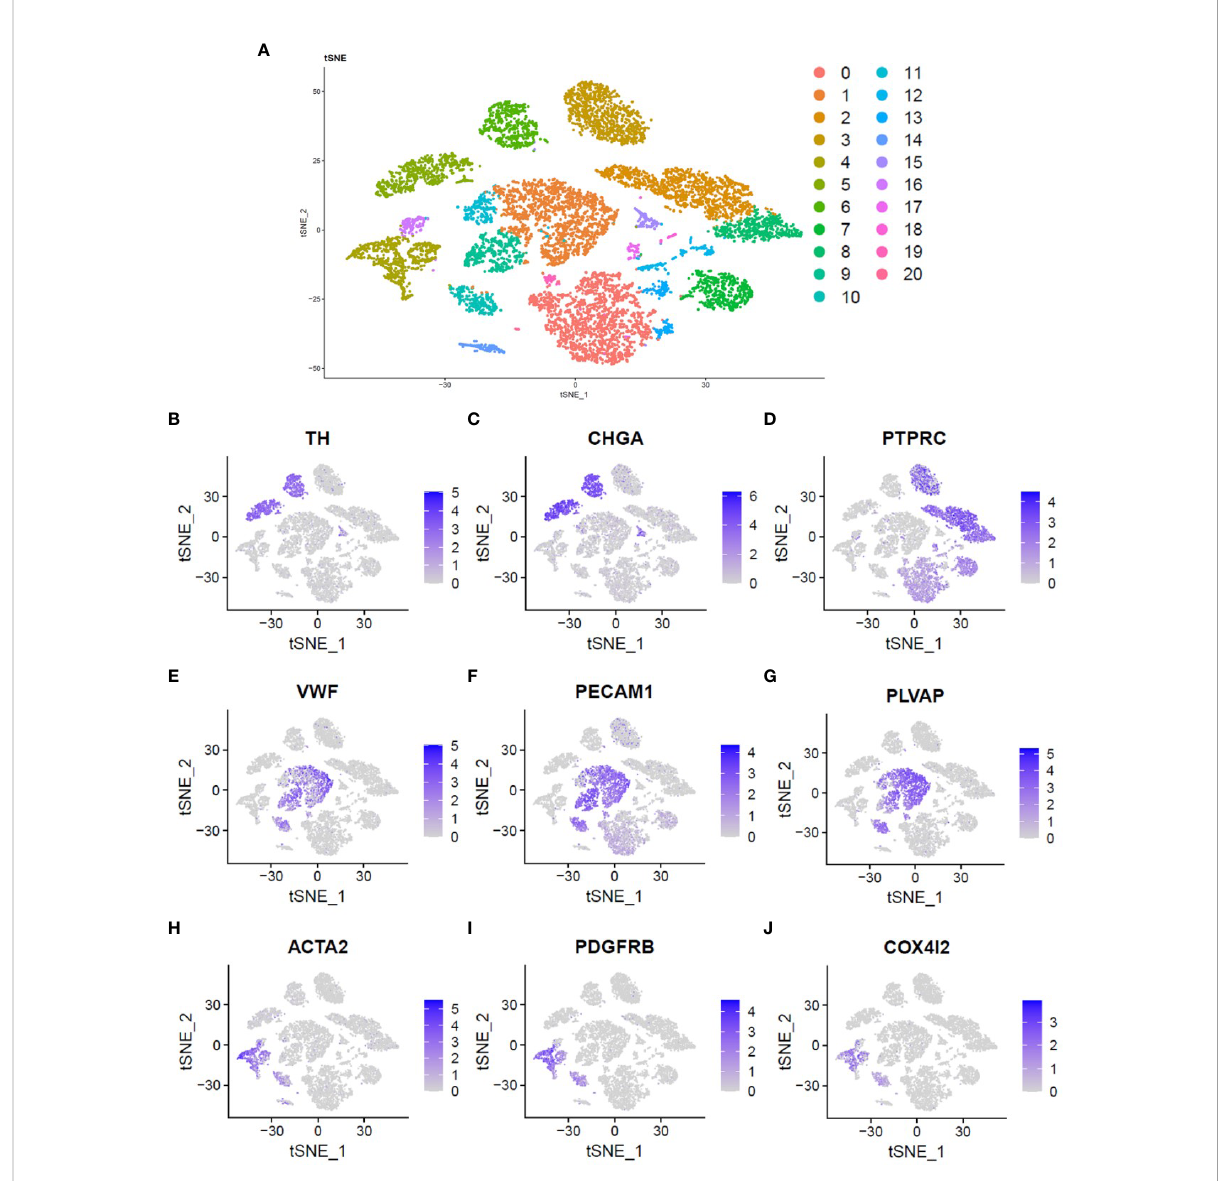
FIGURE 1 Single cell atlas of pheochromocytoma. (A) Two-dimensional t-SNE clustering analysis showed that the cells were divided into 21 clusters and labeled with different colors. (B, C) The expression of TH and CHGA genes was used to identify pheochromocytoma tumor cells. (D) The expression of PTPRC gene was used to identify immune cells. (E – G) The expression of VWF, PECAM1 and PLVAP genes was used to identify endothelial cells. (H, I) The expression of ACTA2 and PDGFRB genes was used to identify fi broblasts. (J) Location and expression of COX4I2 gene in all